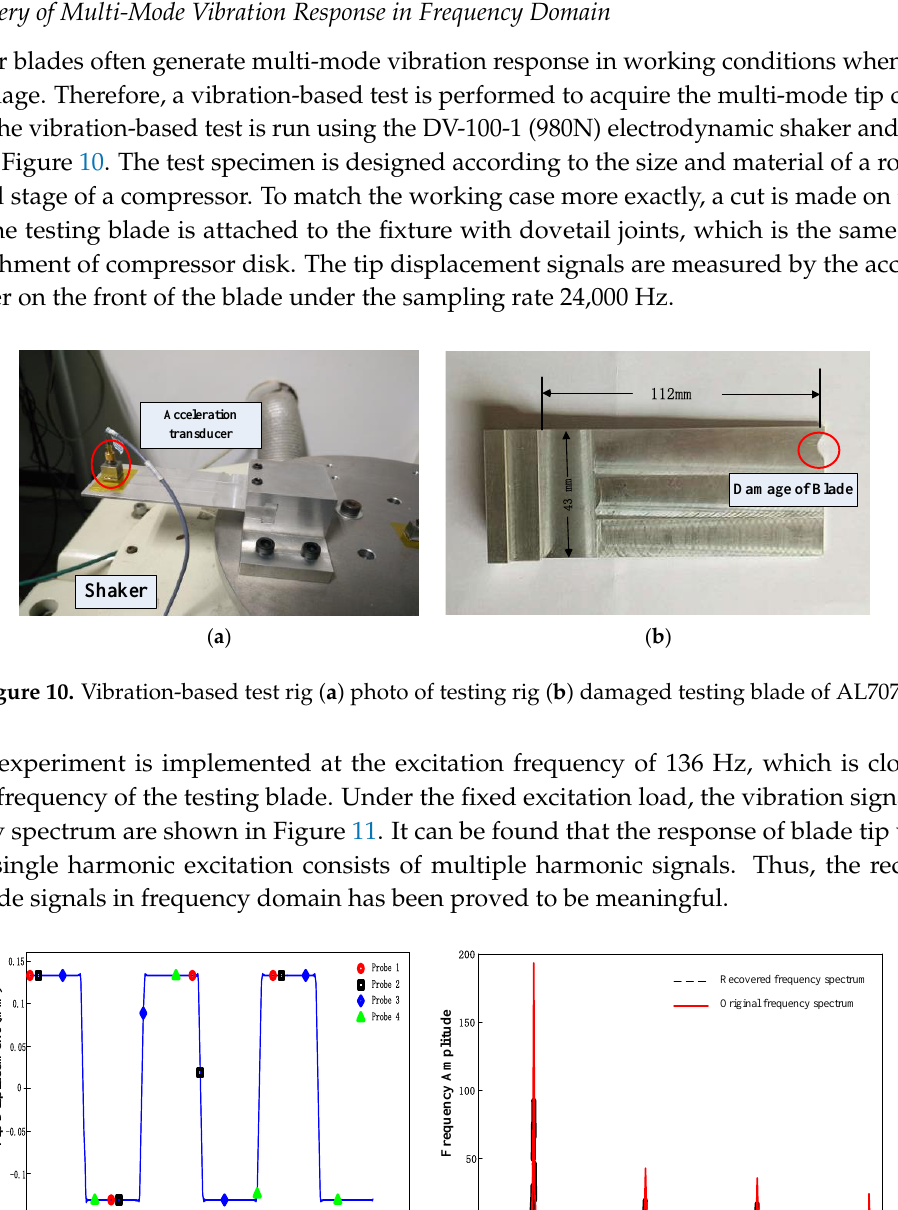
Figure 9. Reconstruction accuracy of BP and BPDN methods using ( a ) 3 probes ( b ) 4 probes ( c ) 5 probes.